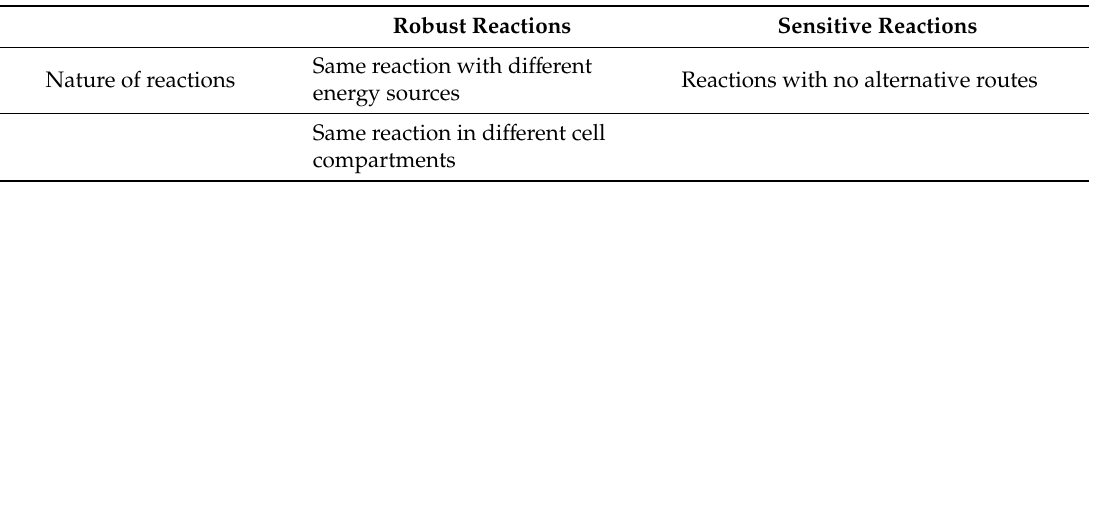
Table 2. Summary of the cellular responses to single reaction deletions within the two sets of reactions isolated in the model (i.e., robusts or sensitives). The predicted responses using flux balance